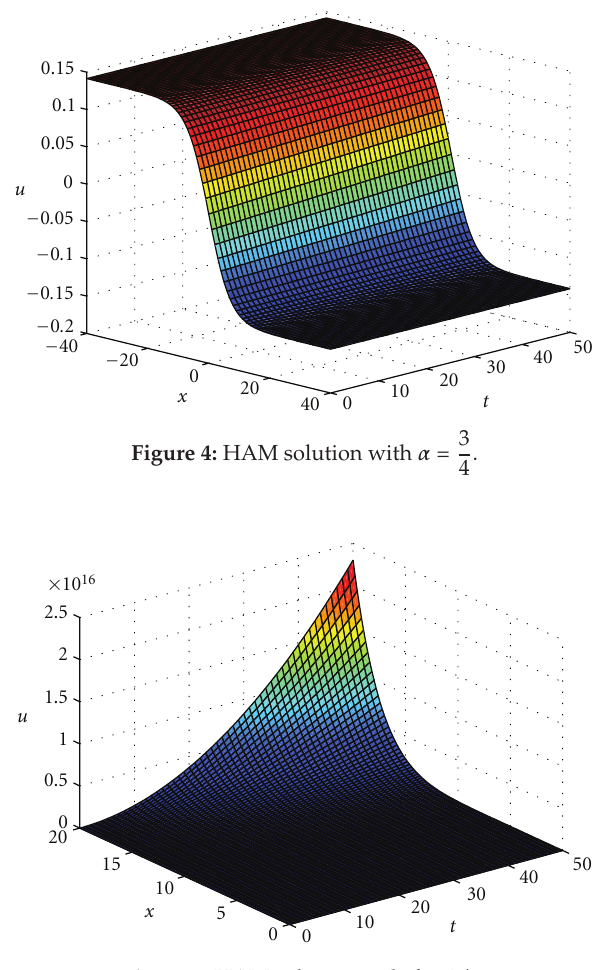
Figure 5: HAM solution with β (cid:8) 1 /